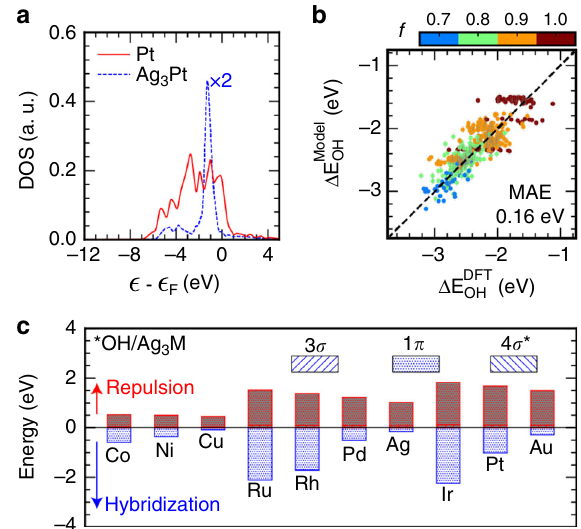
Fig. 4 Model test and interpretation. a The d -states of a transition-metal site exhibit diverse characteristics ranging from bulk-like semi-elliptic bands to free-atom-like discrete energy levels (Pt and Ag 3 Pt as examples). b DFT- calculated vs. model-predicted adsorption energies of *OH at the atop site of {111}-terminated intermetallics and near-surface alloys with one standard deviation. c Partition of *OH adsorption energies at the M site of Ag 3 M into orbital hybridization and orthogonalization of 3 σ , 1 π , and 4 σ * orbitals with the metal d -states. The 3 σ and 4 σ * contributions are too small to be * OH prefers the nearly-parallel adsorption geometry on most of the d -metals to maximize the interaction of the 1 π orbital with metal d -states, while * OH on Na(111) adsorbs more strongly in a up-straight orientation because of a lack of such directional interactions. This orbitalwise insight of chemical bonding could provide guidance in tailoring orbital-speci fi c characteristics of the metal d -band for desired catalytic properties through site engi- neering. Despite an exclusive discussion about the d -metals, it is possible to extend the Bayeschem framework to p -block metals and alloys see Supplementary Fig. 11, unifying the reactivity theory of metal surfaces.